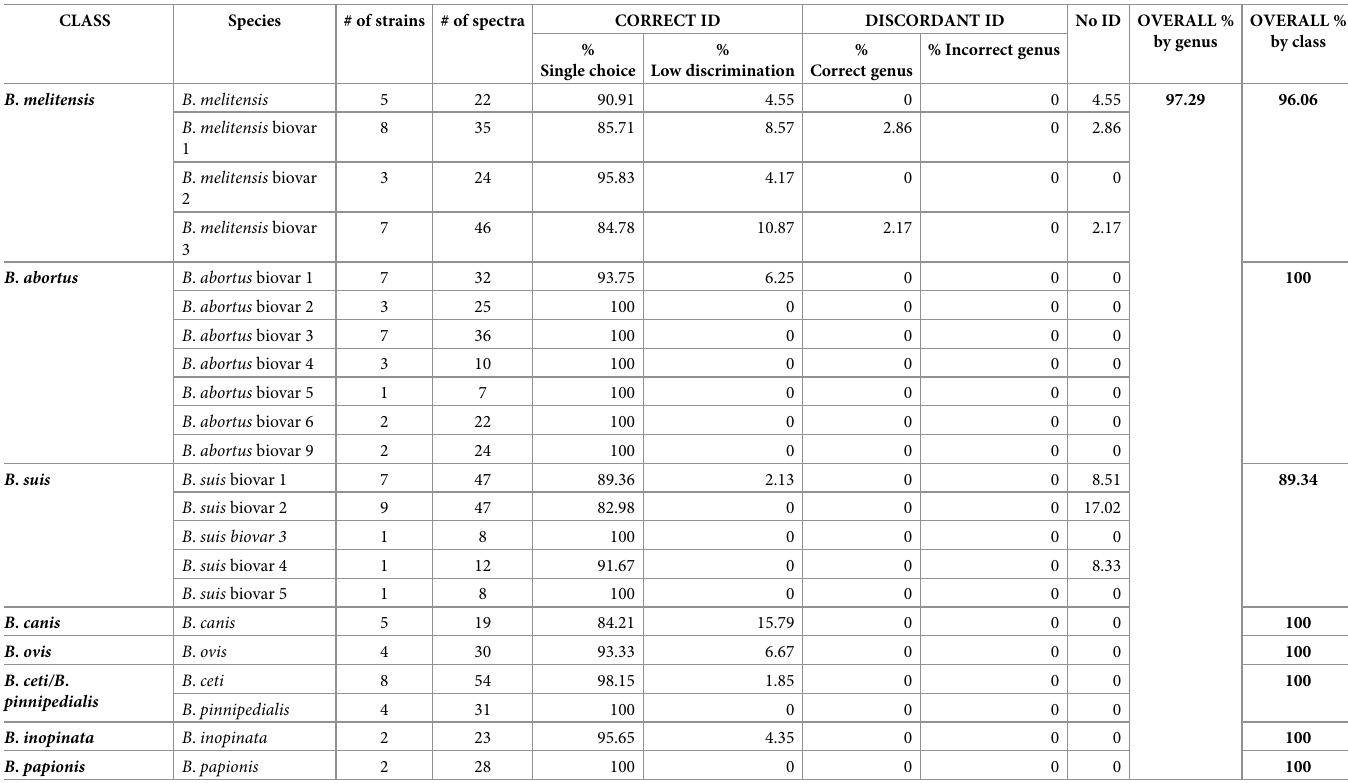
Table 3. Results of identification in cross validation studies. Identifications (ID) results, either at genus or species/class level, were classified as correct (either “Single Choice” or “Low Discrimination”), discordant or no-identification (No ID). This table gives the % of each type of identification results for the indicated species/classes using the updated database.